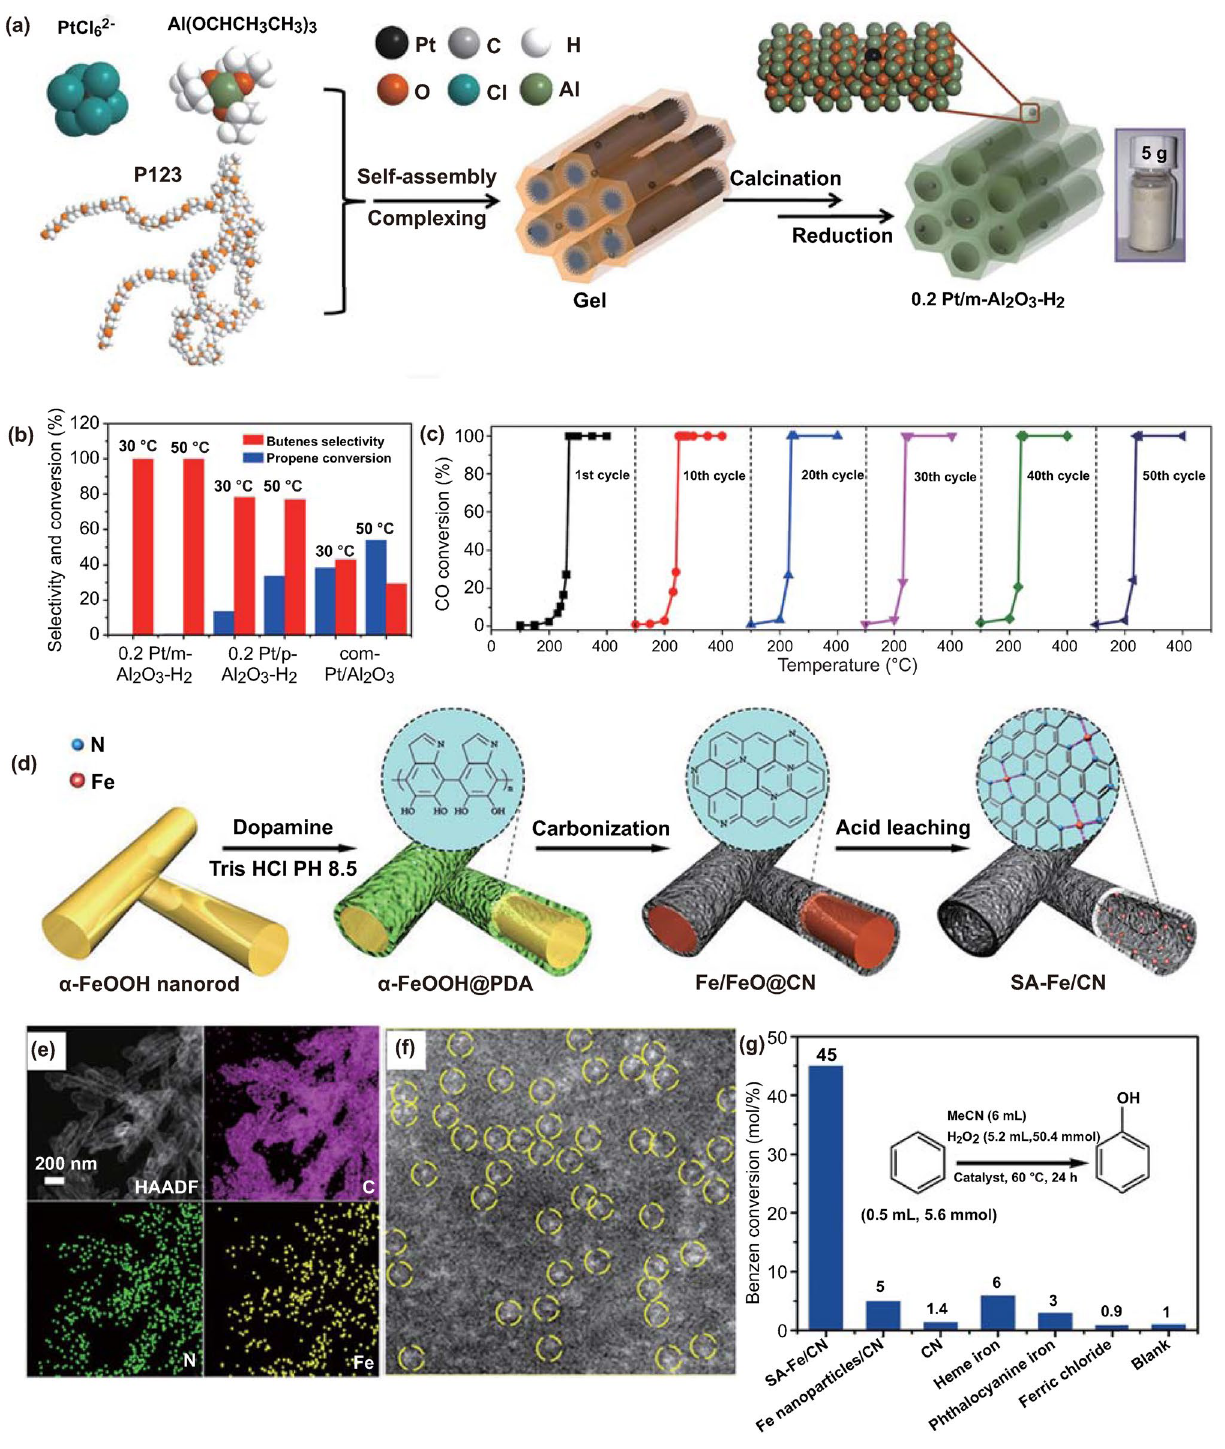
Fig. 6 a Schematic illustration of the 0.2Pt/m-Al 2 O 3 -H 2 synthesis process. b The selectivity of butenes and conversion of propene at 30 and 50 °C. c Conversion of CO from 100 to 400 °C with 1st–50th cycles. a‑c Reproduced from Ref. [100] with permission. Copyright 2017 Springer Nature. d Schematic Illustration of the Synthesis of SA-Fe/CN. e HAADF-STEM image and corresponding EDX mapping of SA-Fe/CN, C (pink), N (green) and Fe (yellow). f AC HAADF-STEM image of SA-Fe/CN. g Benzene conversion catalyzed by the SA-Fe/CN, Fe nanoparti- cles/CN, CN, heme iron, phthalocyanine iron and ferric chloride, respectively. d‑g Reproduced from Ref. [107] with permission. Copyright 2017 American Chemical